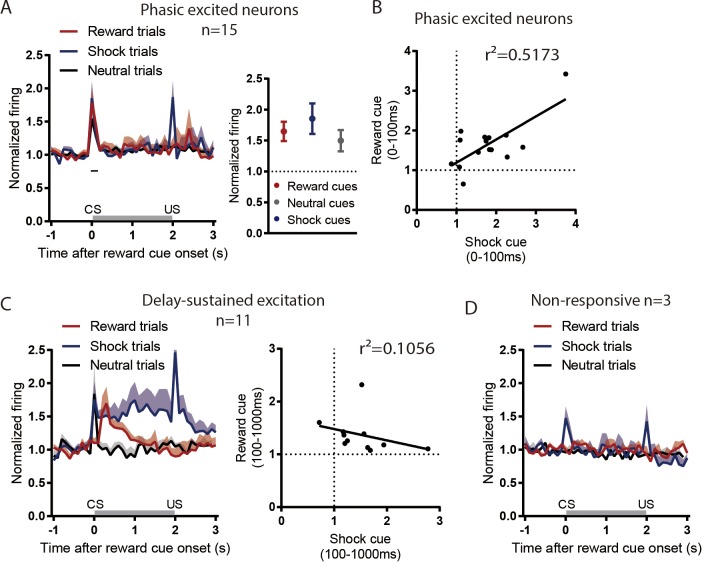
rEPN neurons not inhibited by reward cues do not show valence-like encoding patterns.24 of 53 rEPN neurons were reward cue-inhibited, leaving 29 that were not. Among the non-inhibited neurons, 15, 11, and three neurons showed reward cue phasic excitation (0–100 ms) (A-B), delayed excitation (100–1000 ms) (C), and non-response (D), respectively, to reward cues. Phasically excited neurons did not discriminate between cue types (A), while neurons showing delay-sustained excitation showed sustained responses to both reward-predictive and shock-predictive cues, but not neutral cues, consistent with salience-like encoding (B). Neurons lacking responses to reward cues nonetheless showed phasic excitations to shock-predictive cues but not neutral cues (C).